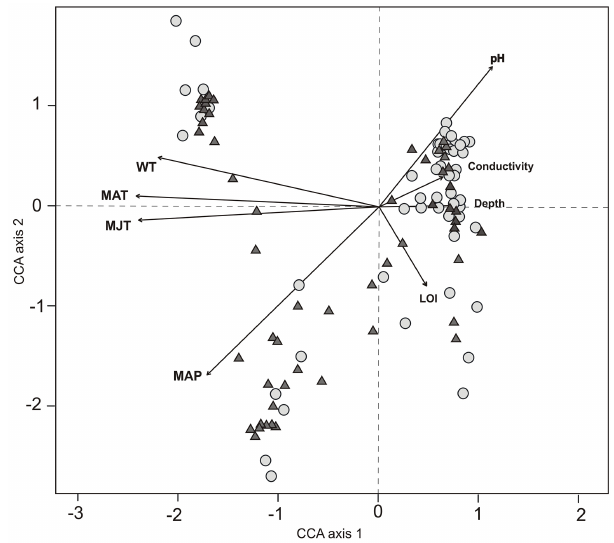
Figure 3. Canonical correspondence analysis (CCA) of the calibra- tion data set lakes and environmental variables with elevation, lon- gitude, and latitude removed after variance inflation analysis. MAP: mean annual precipitation; MAT: mean annual temperature; WT: water temperature; LOI: loss on ignition. Grey circles denote cali- bration lakes; dark grey triangles mark species.